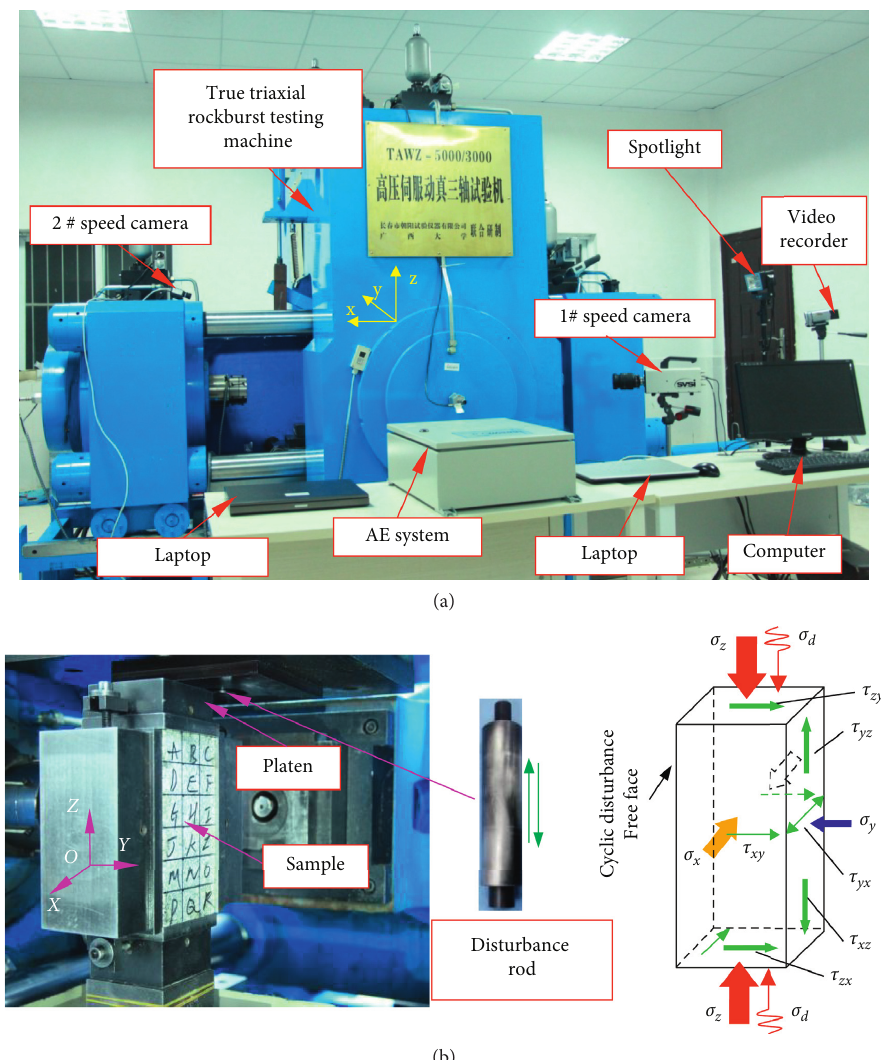
Figure 1: True triaxial experiments of the seismically induced rockbursts (modified after [5, 9]): (a) the true triaxial rockburst testing system, and (b) the loading configuration and the stress state of the rock sample, where σ x , σ y , and σ z are the intermediate, minimum, and maximum static stresses acting on the rock sample; τ xy , τ yz , and τ zx are the shear stresses; and σ d is the seismic disturbance simulated by low-frequency cyclic